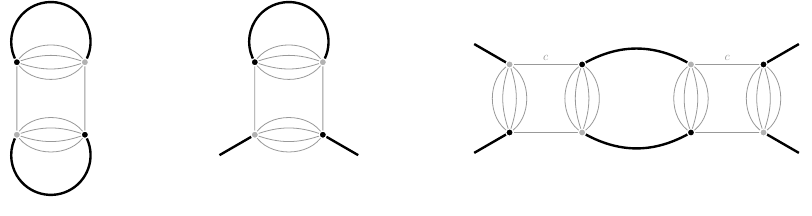
Figure 6: From left to right, the fundamental melons for the 0-, 2- and 4-point func- tion.